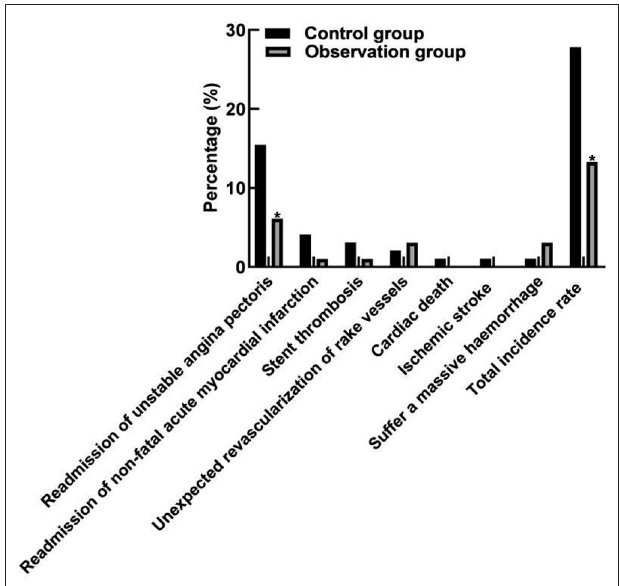
FIGURE 1 | Comparison of MACE event incidence between two groups. Compared with the control group, * P < 0.05.